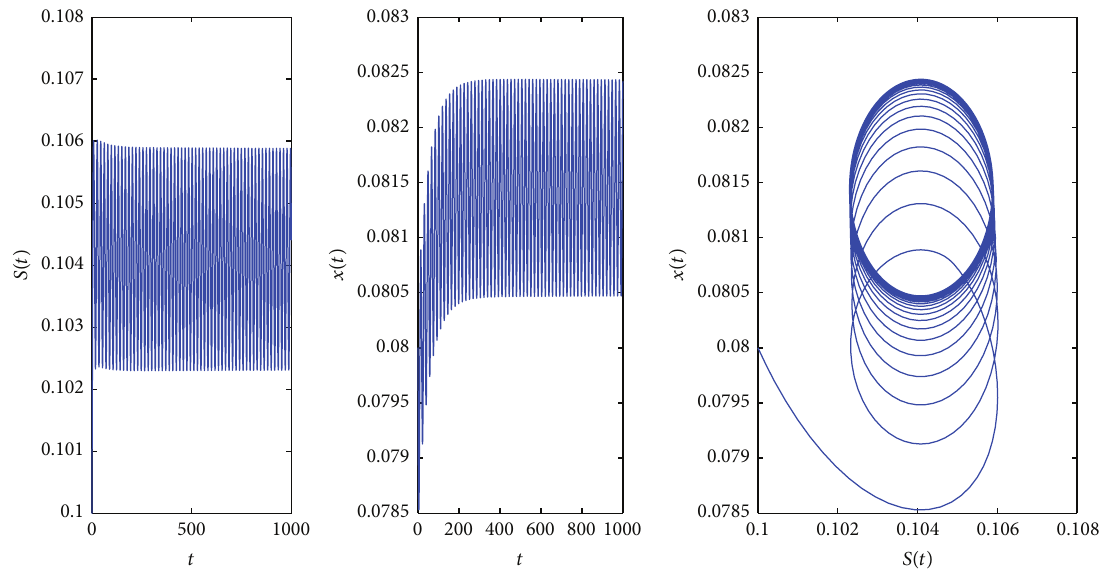
Figure 3: Oscillation solutions with 𝜏 1 = 0 . Parameters are 𝐷 = 0.01 , 𝐷 1 = 0.5 , 𝛾 = 0.8 , 𝑘 = 0.1 , 𝑎 = 1 , and 𝑆 0 = 1 . The time delay is = 12.217 . 𝜏 2